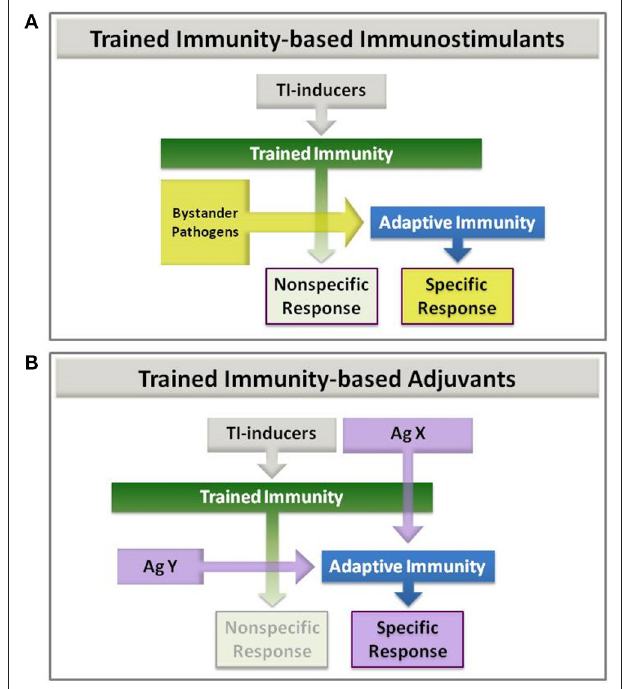
FIGURE 3 | Trained Immunity-based Immunostimulants (A) and Adjuvants (B) . (A) Immunostimulants: trained immunity (TI) inducers that enhance both nonspecific and adaptive immune responses to eventual bystander pathogens. (B) Adjuvants: trained immunity (TI) inducers that are combined with an antigen. This latter can be co-delivered with the TI-inducers in the same vaccine (AgX), or later on (AgY) in a two-step process, once trained immunity has been